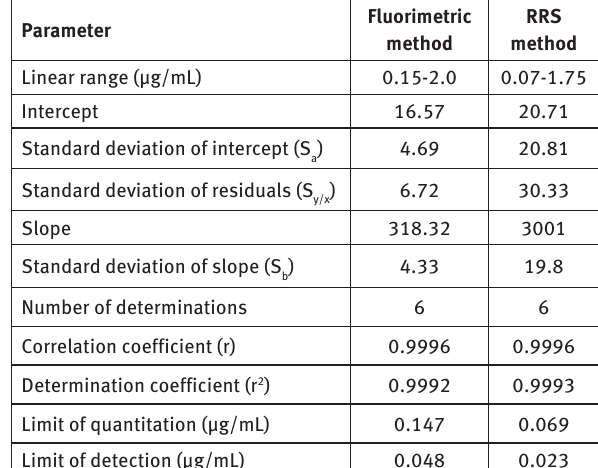
Table 1: Analytical parameters for the determination of CZP by the proposed spectroscopic